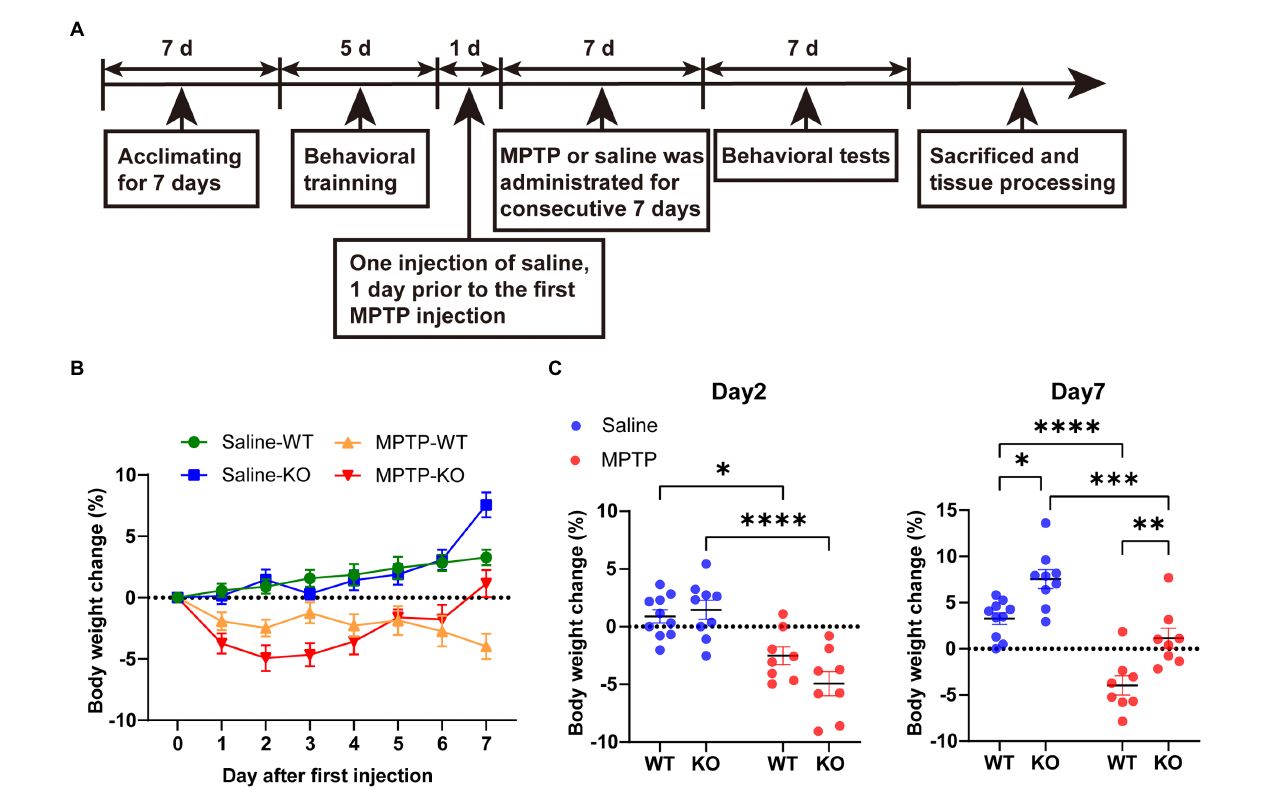
FIGURE 1 MPTP treatment. (A) A schematic diagram of MPTP treatment in Rab39b KO and WT mice. (B) Percentage of body weight change in MPTP-treated Rab39b KO and WT mice or respective saline-treated control mice at different time points after first MPTP injection. (C) Percentage of body weight change in MPTP-treated Rab39b KO and WT mice or respective saline-treated control mice on days 2 and 7 after first MPTP injection, respectively. Data represent mean ± SEM, n = 10 for Saline-WT, n = 9 for Saline-KO, and n = 8 for both MPTP-WT and MPTP-KO. * p < 0.05, ** p < 0.01, *** p < 0.001, **** p < 0.0001, two-way ANOVA followed by Tukey’s post hoc